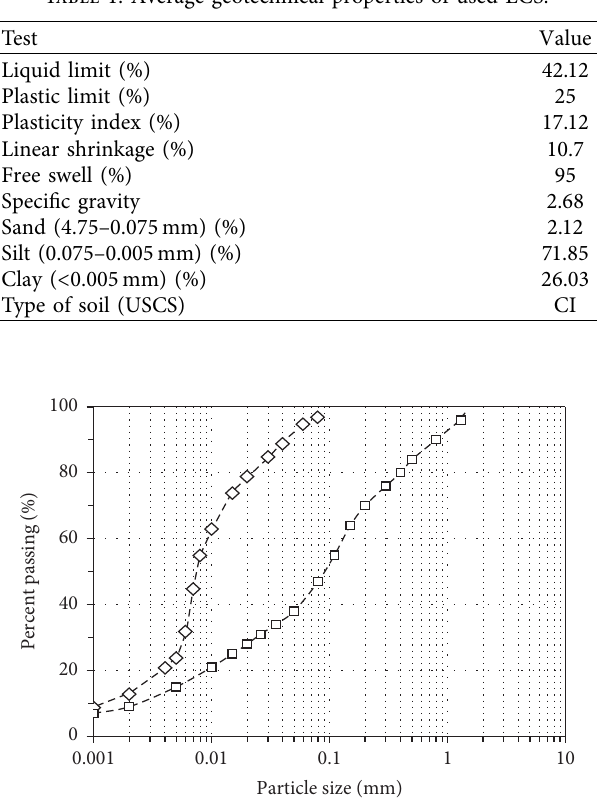
Table 1: Average geotechnical properties of used ECS.